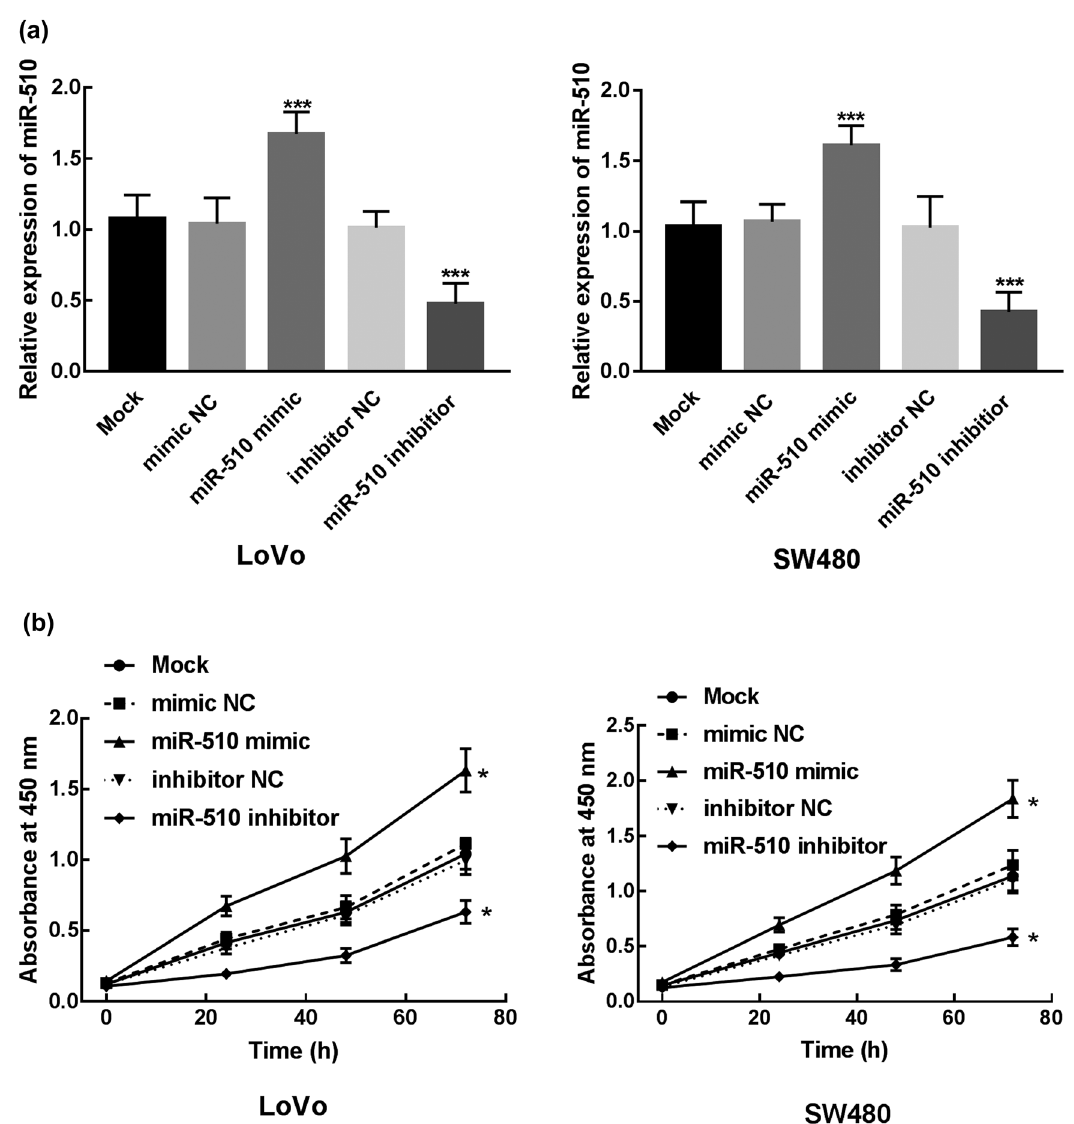
Figure 3: Cell transfection and its e ff ect on the proliferation of colon cancer cells. ( a ) Transfection of miR - 510 mimics signi fi cantly increased the expression of miR - 510 in LoVo and SW480 cells, while the transfection of miR - 510 inhibitor signi fi cantly decreased the expression of miR - 510 in LoVo and SW480 cells, indicating the transfection was successful ( *** P < 0.001 ) . ( b ) Overexpression of miR - 510 signi fi cantly enhanced the proliferation of LoVo and SW480 cells, while the knockdown of miR - 510 signi fi cantly inhibited the proliferation of LoVo and SW480 cells ( * P < 0.05 )